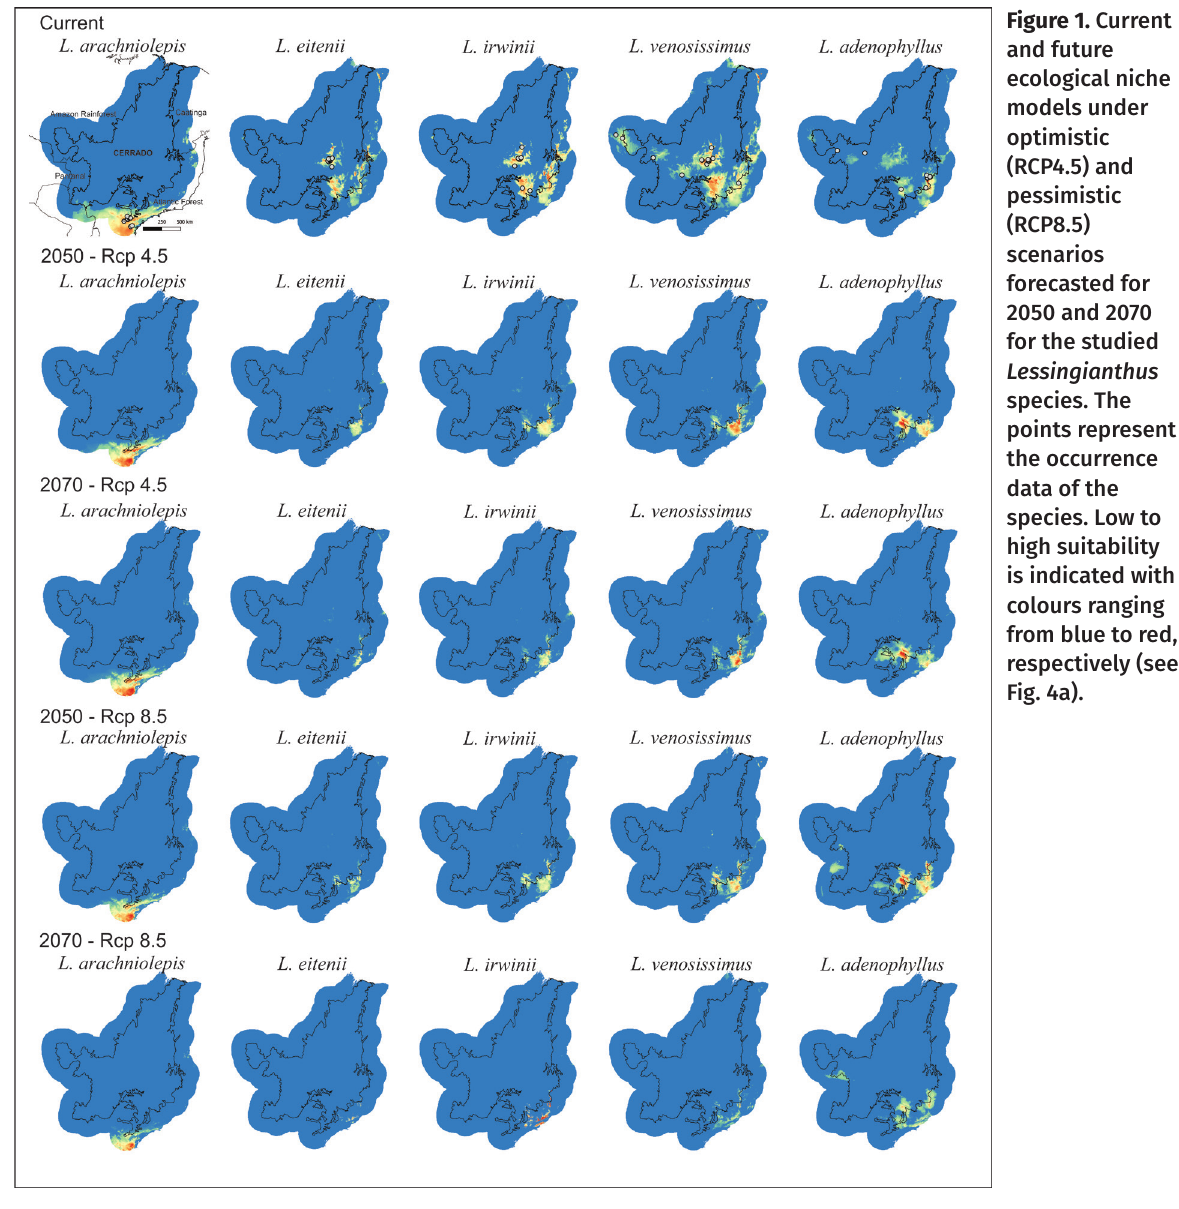
Figure 1. Current and future ecological niche models under optimistic (RCP4.5) and pessimistic (RCP8.5) scenarios forecasted for 2050 and 2070 for the studied Lessingianthus species. The points represent